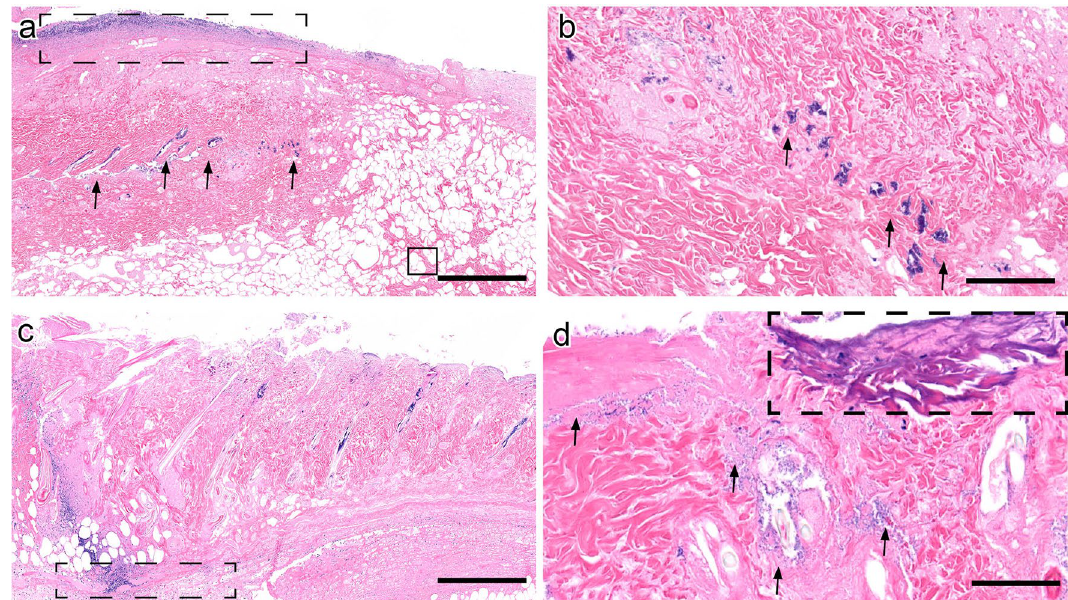
Figure 3. Histopathology of murine pressure ulcers infected with MRSA and given vehicle control or topical mupirocin treatment. (A ) In vehicle control animals, pressure ulcers were severe, with necrosis extending into the deep dermis and subcutis. A myriad of superficial bacteria were present as a crust on the ulcerated lesion surface (dashed box). Bacterial colonies often extended into the deep dermis (arrows) (image acquired